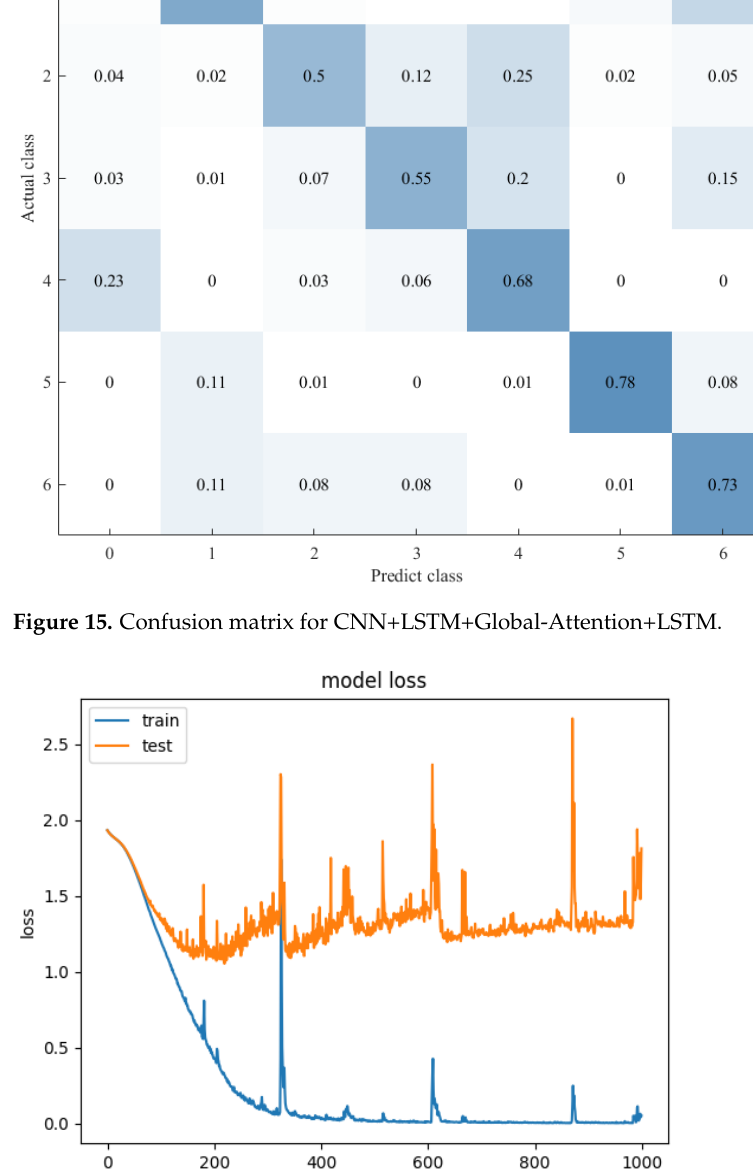
Figure 17. Model loss for CNN+LSTM×2+Global-Attention. In order to explore the influence of the form of attention on the performance of the model, we established the CNN+LSTM×2+Self-Attention model. We compared it with the CNN+LSTM×2+Global-Attention model and the convergence rate of the two models was not much different, which was shown in Figures 17 and 18, but the accuracy of the former model was low. Moreover, after the convergence point of the former is passed, the oscil- lating range of the LOSS value is relatively large, which suggests that models with self- attention have a greater tendency to overfitting. The experiments results are shown in Table 3.